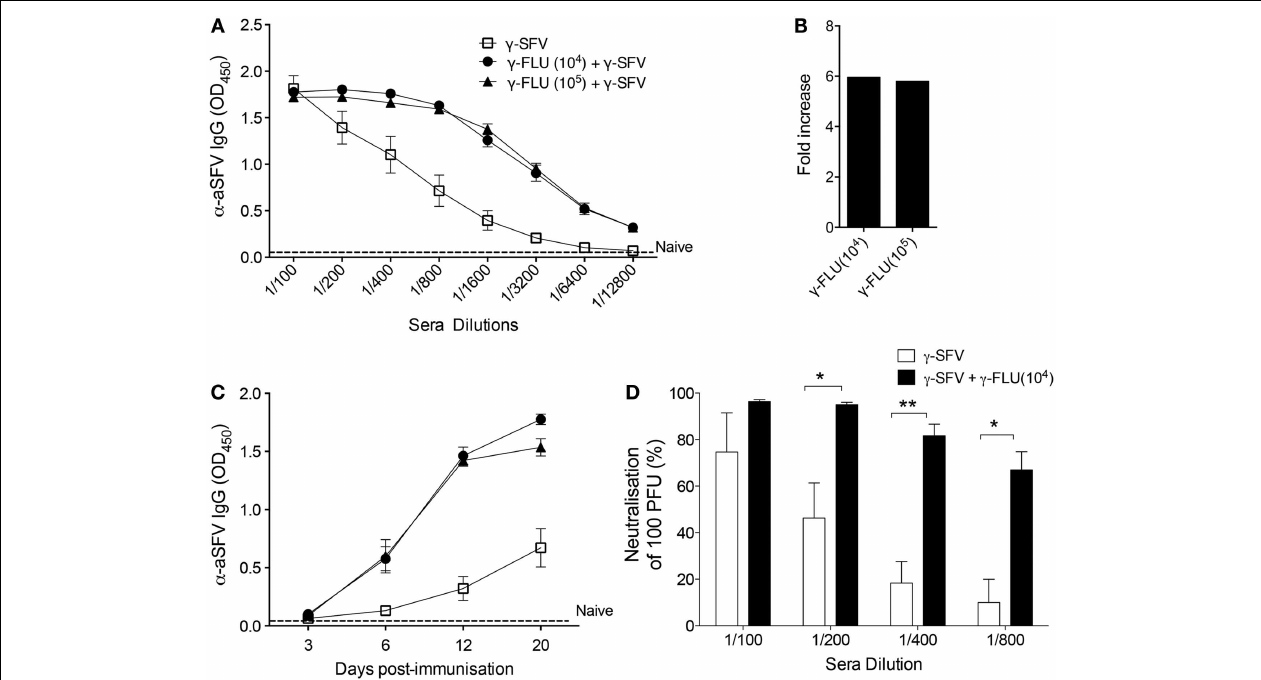
(B) Folds increase in SFV-specific IgG antibody titers based on the absorbent value of 0.5 for the tested serum dilutions (A) . (C) Serum SFV-specific IgG levels were analyzed by direct ELISA using a serum dilution of 1/800 at 3, 6, 12, and 20days post-vaccination. (D) Neutralization of SFV by the immune sera collected at day 20 post-vaccination as determined by plaque reduction assay. Data represent mean ± SEM ( n = 3), * p < 0.05, ** p < 0.01.